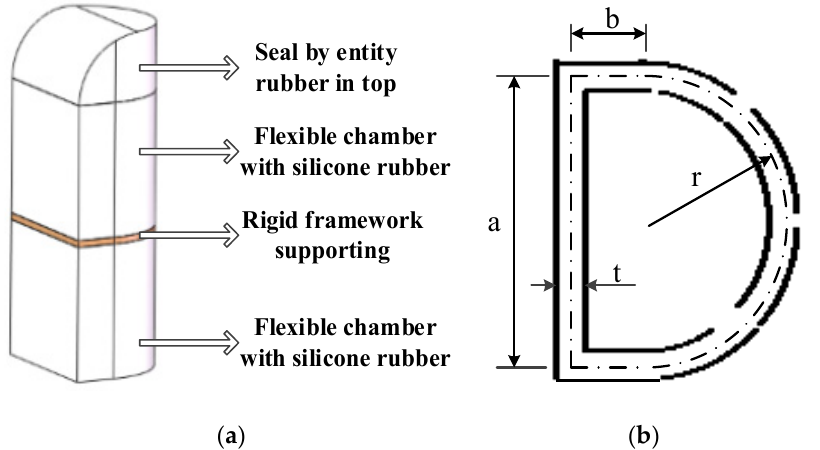
Table 3. Parameters in Figure 12.